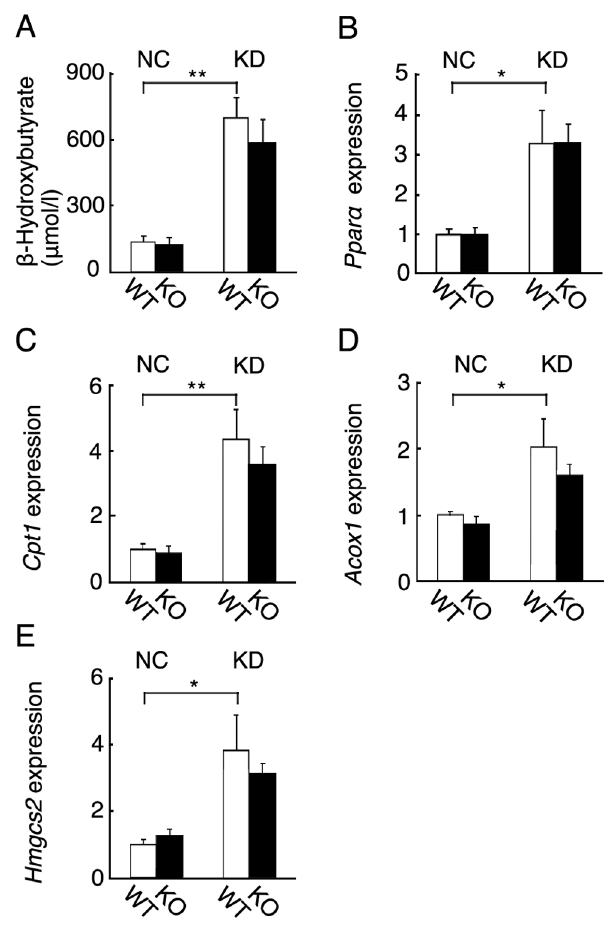
Figure 5. Hepatic ketogenesis of wild-type and Fgf21 knockout mice. (A) Blood b -hydroxybutyrate levels in 3-month-old wild-type (WT) and Fgf21 knockout (KO) mice fed NC or KD for 6 days. (n=12–14 mice per group; **, P , 0.01). (B–E) Hepatic expression of genes involved in ketogenesis including Ppara , Cpt1 , Acox1 , and Hmgcs2 in wild-type (WT) and Fgf21 knockout (KO) mice fed NC or KD for 6 days. (n=7–9 mice per group; *, P , 0.05; **, P , 0.01).